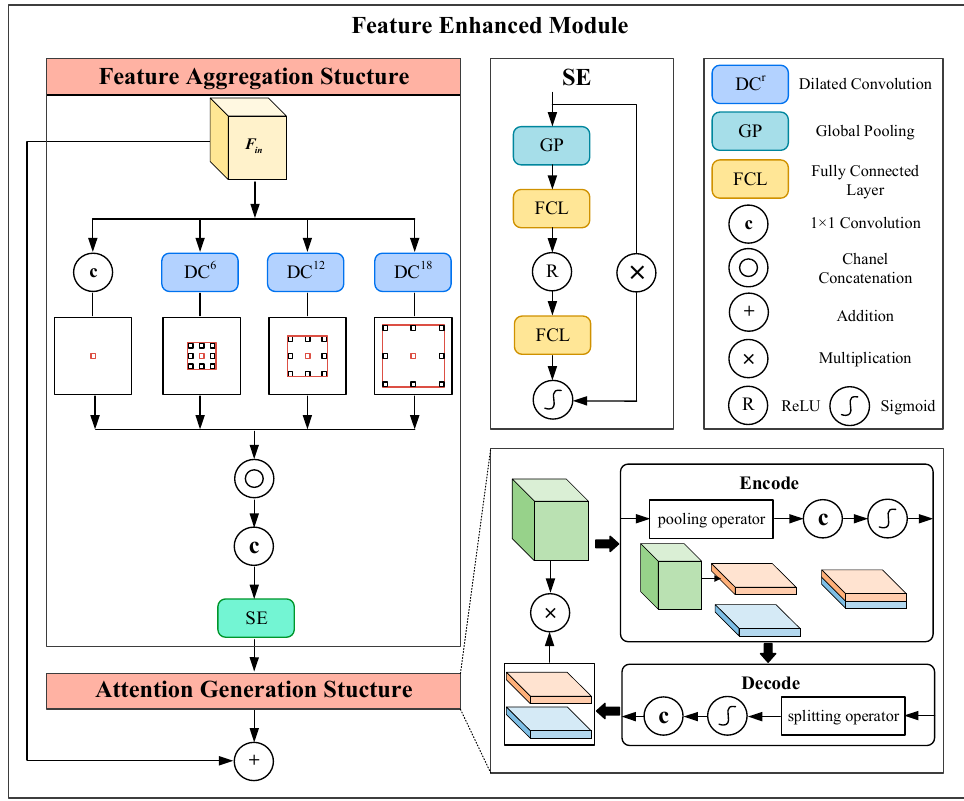
Figure 2. The structure of FEM .